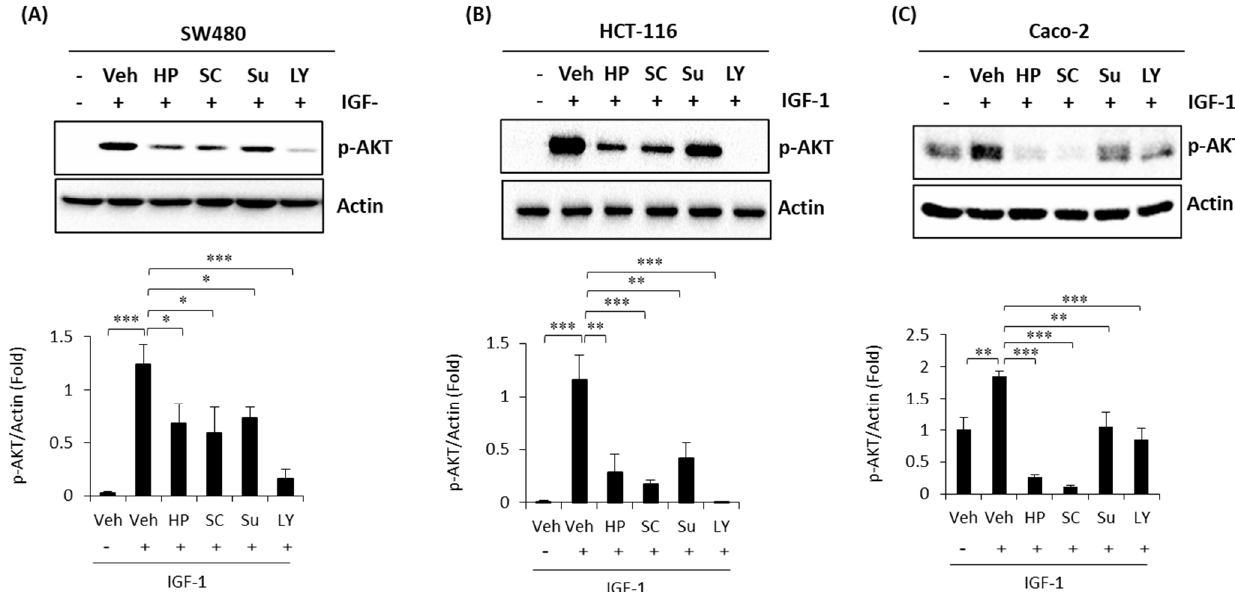
Figure 4. High phenolic sorghum bran extracts weaken the IGF-1-stimulated PI3K/AKT pathway in human colon cancer cells. SW480 ( A ), HCT-116 ( B ) and Caco-2 ( C ) cells were pretreated with sorghum bran extracts (HP, SC, Sumac; 2.5 mg/mL) and LY294002 (selective inhibitor of PI3K; 50 µM) for 6 h and then co-treated with IGF-1 (100 ng/mL) for 2 h. Western blot was performed for phospho-AKT and actin. Su, Sumac; LY, LY294002 (selective inhibitor of PI3K). Values are the mean ± SD ( n = 3). Significant differences between two groups are indicated as * p < 0.05, ** p < 0.01, *** p < 0.001.